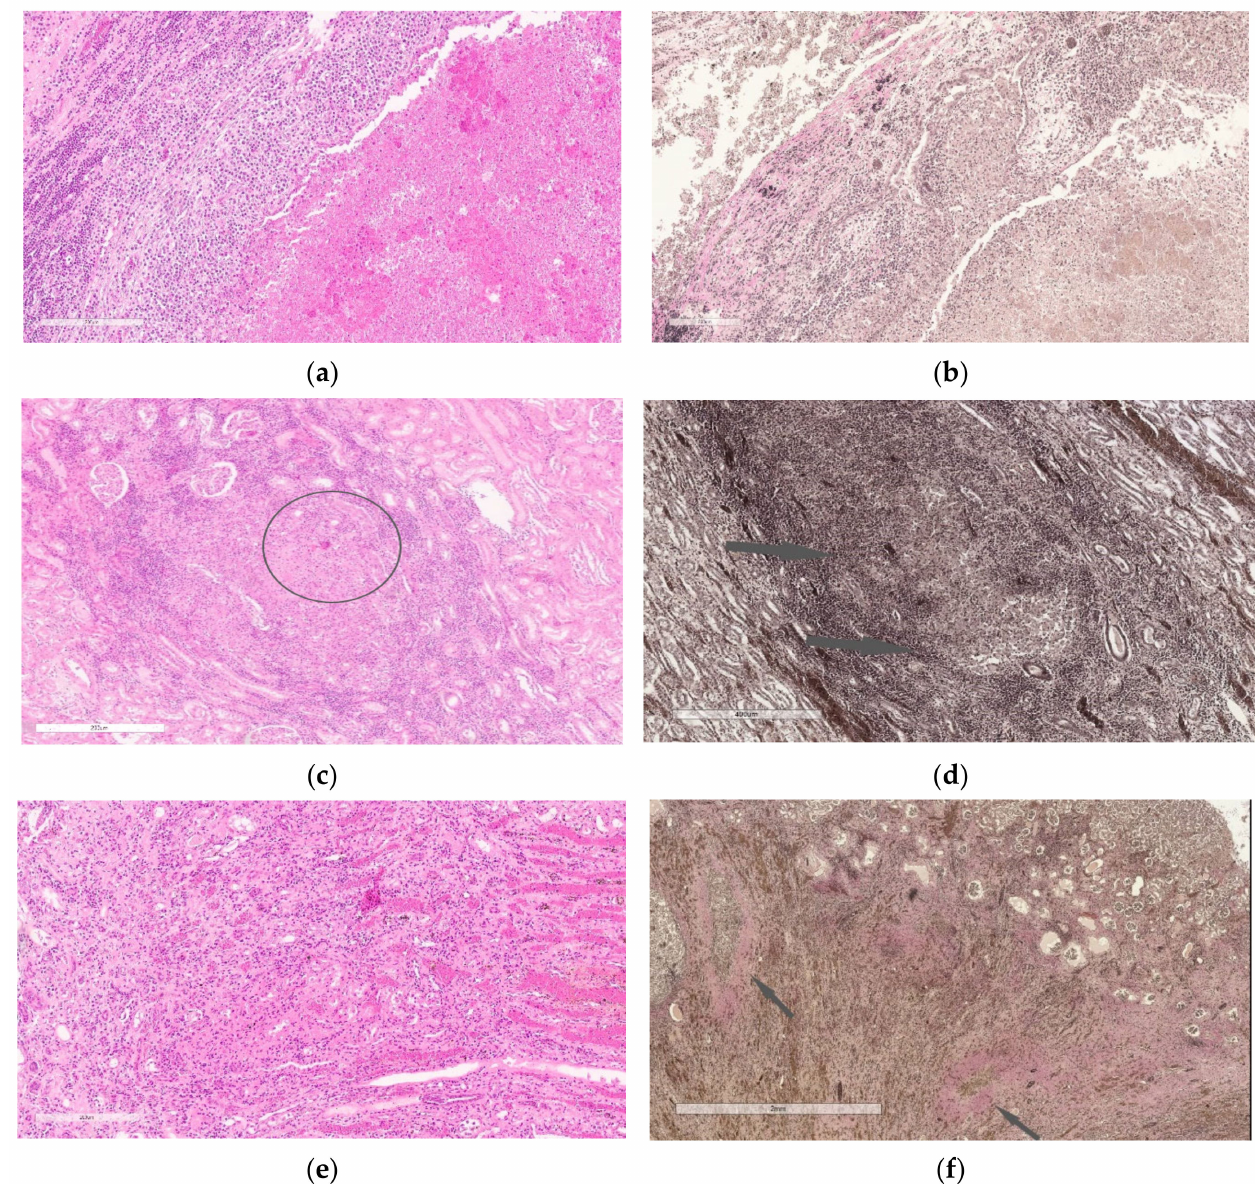
Figure 5. ( a , b )—Kidney of the first group rabbit 3 months after the challenge. A large focus of destruction with a developing three-layer wall and a focus of specific infiltration with necrosis in the center ( a , b ). Staining with hematoxylin and eosin ( a ), Van Gieson ( b ). Scale bar, 200 µ m ( a ). Scale bar, 200 µ m ( b ). ( c , d )—Kidney of the second group rabbit, which received anti-tubercular chemotherapy within 3 months after the challenge. Focus of specific inflammation with slight necrosis in the center (highlighted circle) and moderately pronounced lymphoid infiltration along the periphery ( c ); mature connective tissue is absent, initial signs of connective tissue formation (indicated by arrows) ( d ). Staining with hematoxylin and eosin ( c ), Van Gieson ( d ). Scale bar, 200 µ m ( c ). Scale bar, 400 µ m ( d ). ( e , f )—Kidney of the third group rabbit, which received MSCs after completion of 3-month anti- tubercular chemotherapy. Granulation tissue with signs of maturation ( e ), foci of mature connective tissue (indicated by arrows) with accumulations of macrophages in the center of the foci ( f ). Staining with hematoxylin and eosin ( e ), Van Gieson ( f ). Scale bar, 200 µ m ( e ). Scale bar, 200 µ m ( f